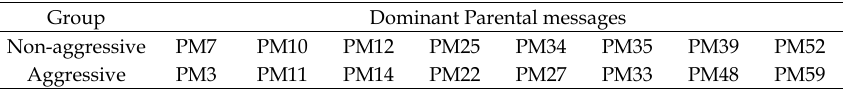
Table 3. Dominant Parental Messages in Non-aggressive and Aggressive Teenagers Group Dominant Parental messages